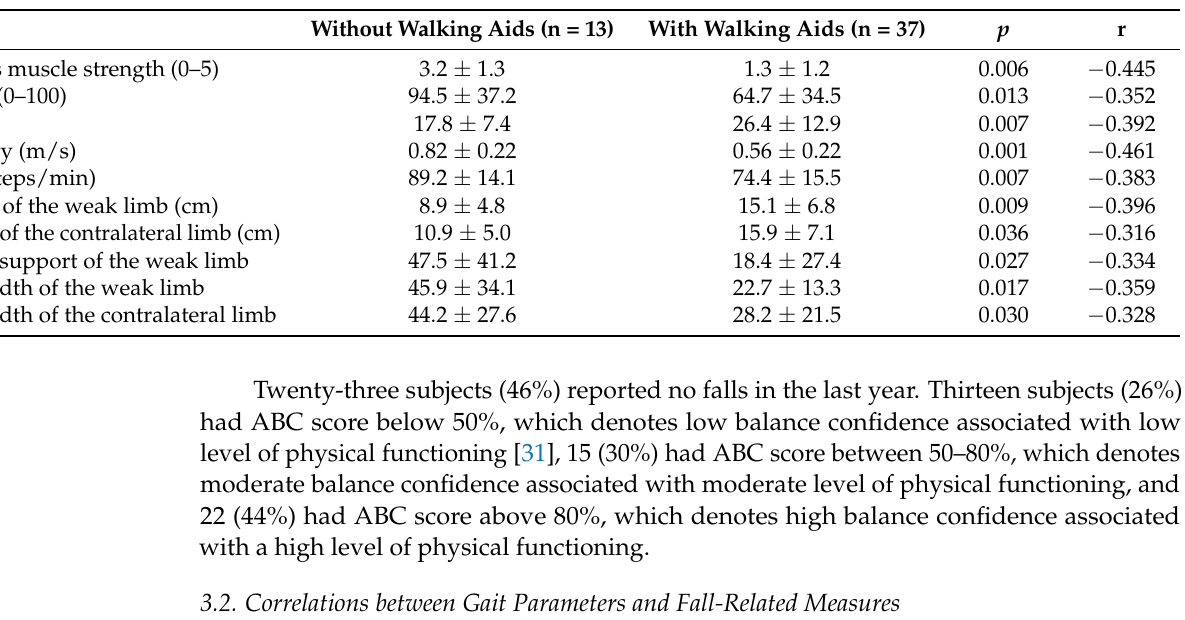
Table 2. Significant differences found in all study measures between subjects who did not require an orthotic and/or assistive device compared to the subjects who required an orthotic and/or assistive device. Measures include: The Activities-specific Balance Confidence Scale = ABC score, and the Timed up and Go (TUG). CV = Coefficient of Variability.